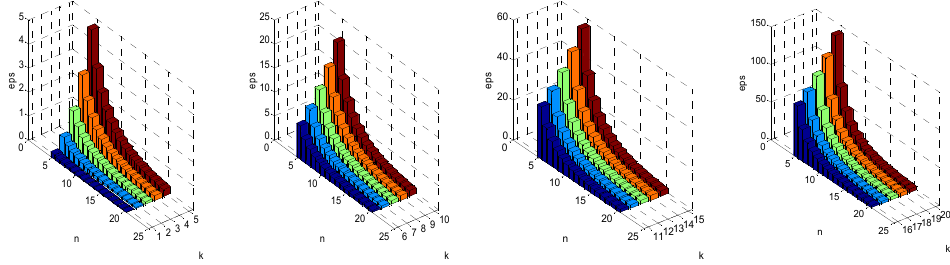
Figure 5. Relative errors with different combinations of segment number and harmonic order.